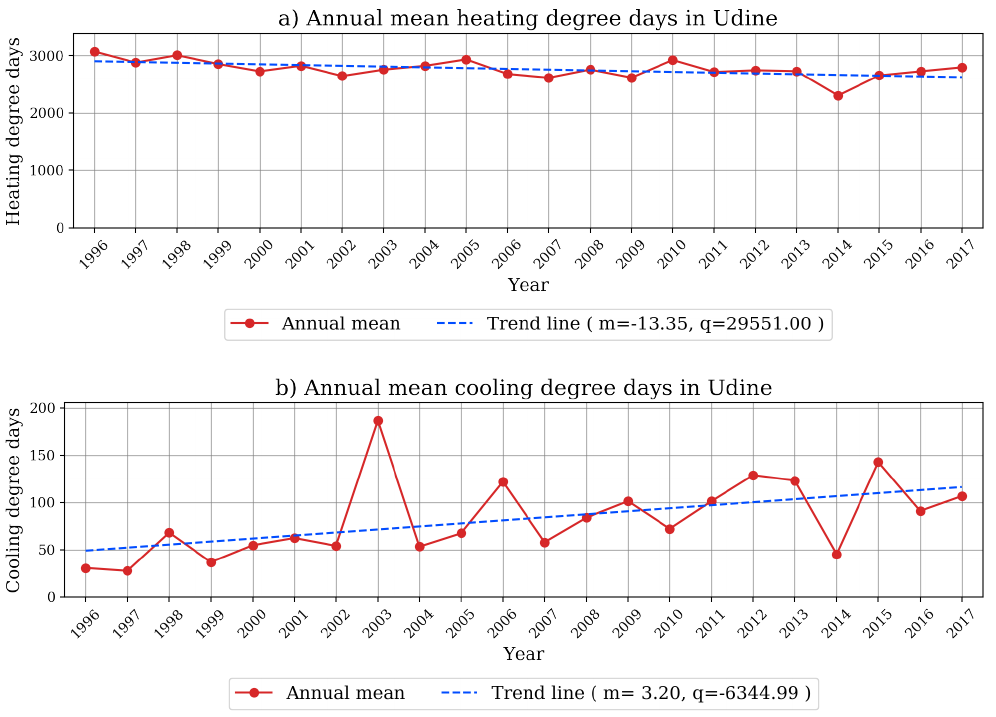
Figure 4. Annual mean heating degree days ( a ) and cooling degree days ( b ) in Udine for each year considered in the multi-year.